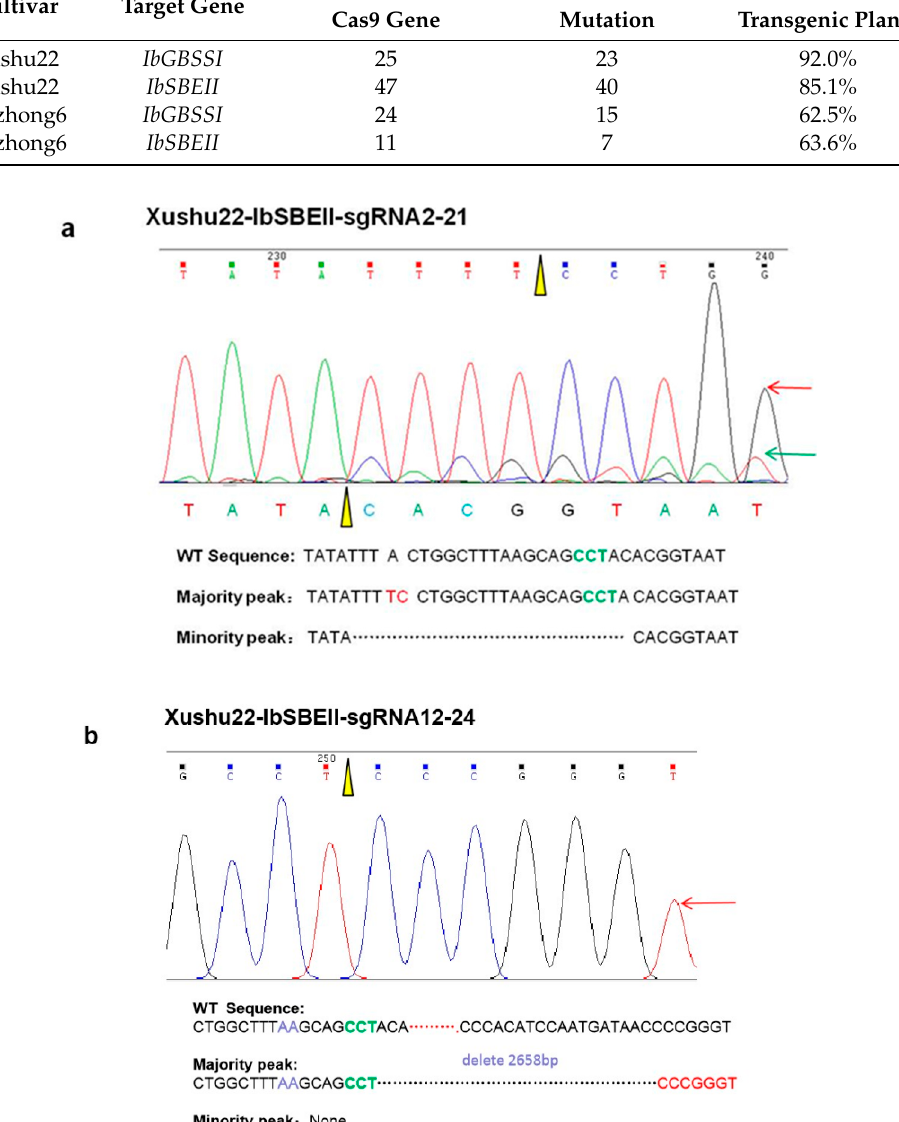
Figure 3. The typical sequence chromatograms of CRISPR / Cas9 editing produced targeted gene mutations. ( a ) Xushu22-IbSBEII-sgRNA2-21 multiple peaks appearance. Majority peak TC replace of A in wildtype sequence, while minority peak has a short sequence deletion compared with WT sequence. Dots indicate deletion sequences. Orange triangles indicate the position of sgRNA target site. ( b ) Xushu22-IbSBEII-sgRNA12-24 has a 2658 bp sequence deletion compared with WT sequence. Black dots indicate deletion sequences. An orange triangle indicates the position of sgRNA target site. Red line: T; green line: A; blue line: C; black line: G. In Taizhong6, of the 15 IbGBSSI-sgRNA2 transgenic lines, two lines had insertions, five lines had single point mutations, one line combined a single site mutation and an insertion, and another line had both a point mutation and a deletion (Table S1). The same mutation, AAC to GTT, occurred in IbGBSSI-sgRNA12 lines 3, 5, 6, and 7. A single point mutation and a deletion occurred in IbGBSSI-sgRNA12-10 transgenic line. In IbGBSSI-sgRNA2 transgenic lines, six lines had single point mutations and one line had both a single point mutation and a deletion. In IbSBEII-sgRNA12 transgenic lines, two lines had short deletions (Table S1). Sequencing results revealed that